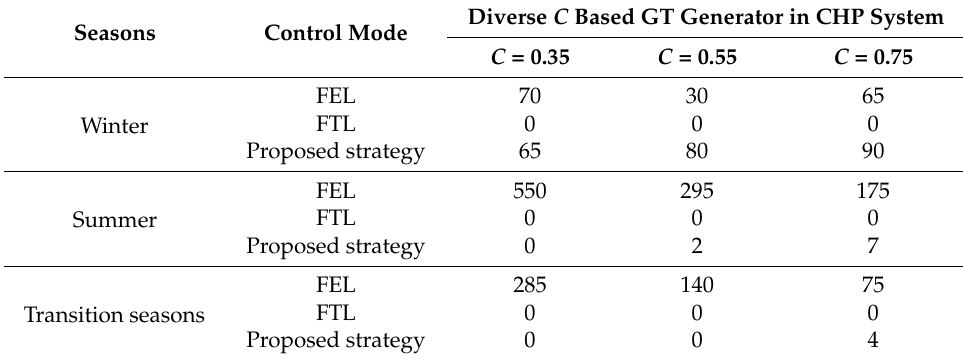
Table 7. Thermal energy storage requirements in different scenarios (unit: MW · h).